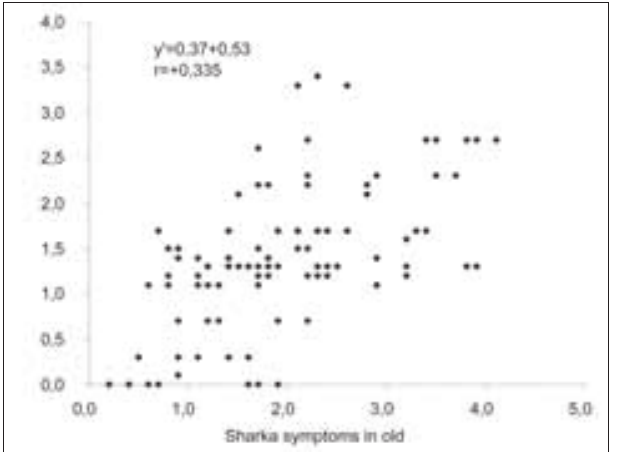
Figure 3. Sharka symptoms depending in the extent of cultivars